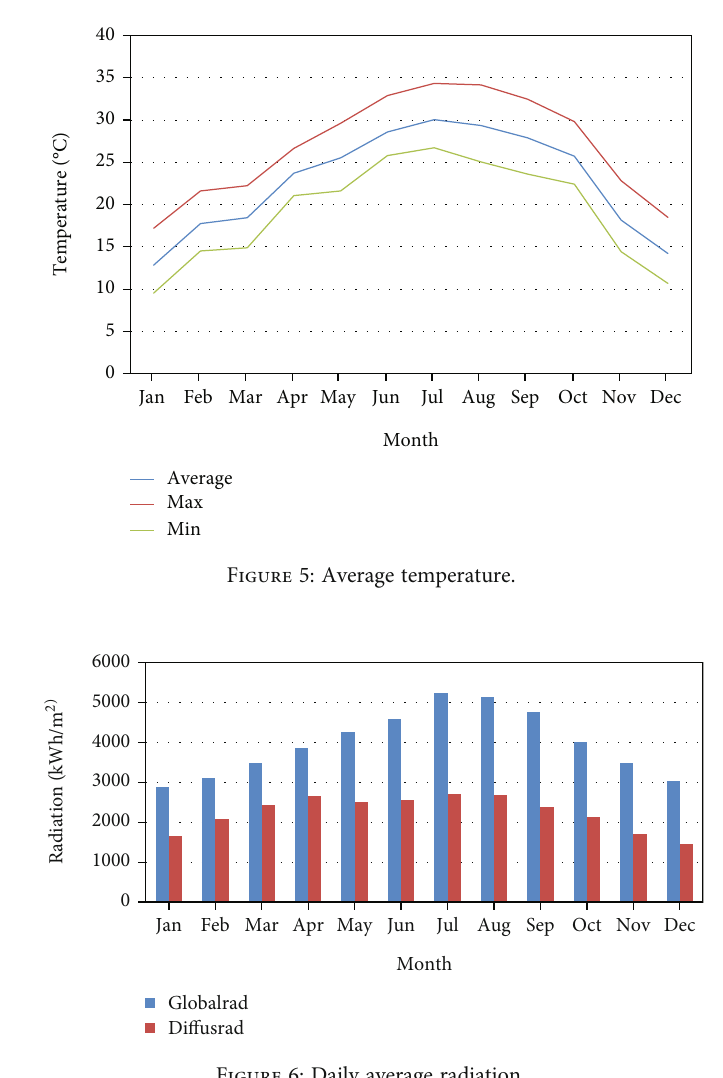
Figure 6: Daily average radiation.